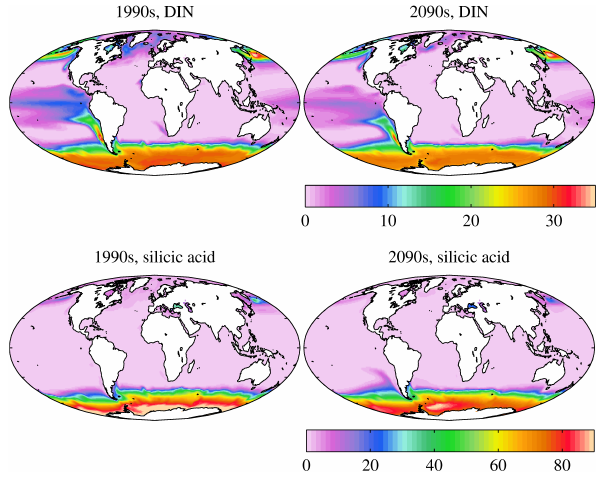
Fig. 12. Annual average 1990s (left) and 2090s (right) surface DIN Fig. 10. Annual average 1990s ( left ) and 2090s ( right ) surface DIN ( top ; mmol N m − 3 ) and surface silicic acid ( bottom ;mmolSim − 3 ). (top; mmolNm − 3 ) and surface silicic acid (bottom; mmolSim − 3 ).